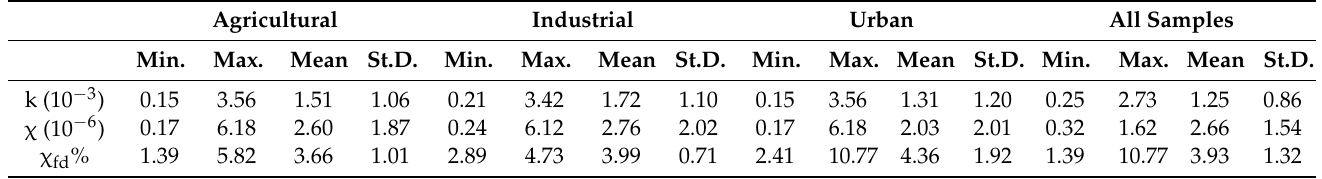
Table 3. Descriptive statistics of k, χ , and χ fd % values in different land-use